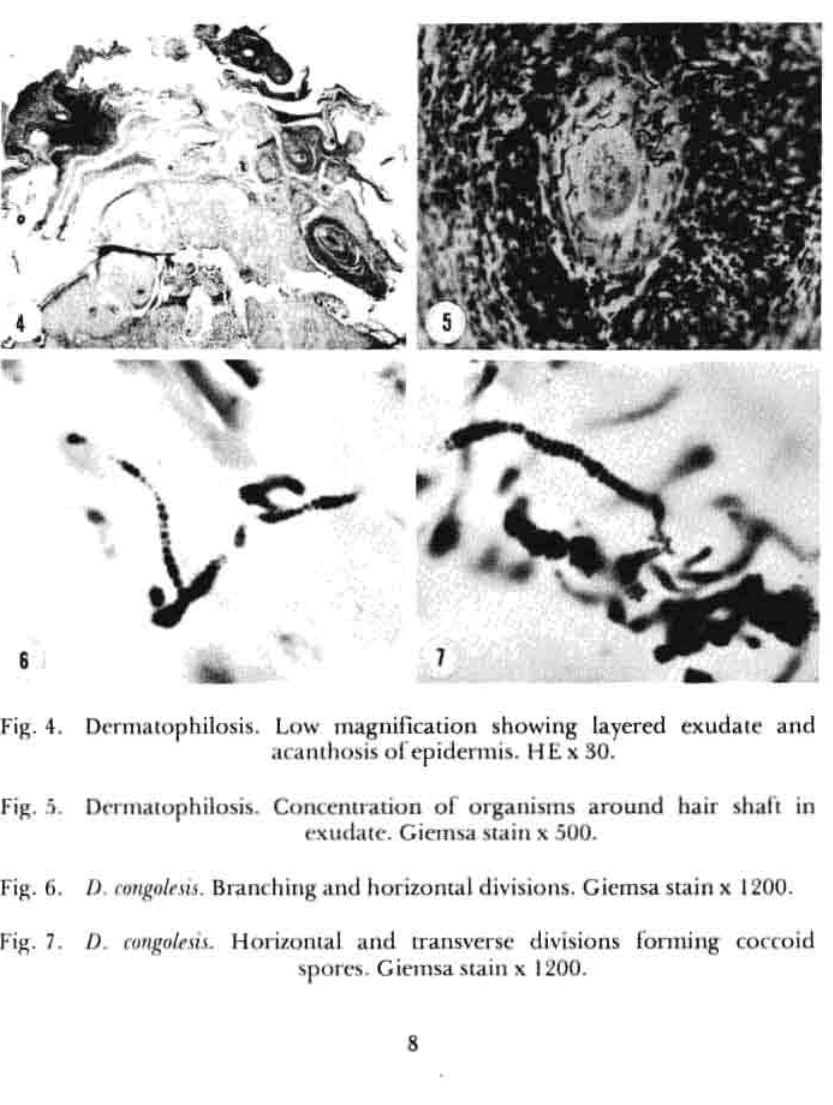
Fig. 4. Derma tophi los i s. Fig. 5. Dennatophilosis. Fig. 6. D. cOllgoltJjs. Branching and horizontal divisions. Giemsa Slain x I ZOO. Fig. 7. D. (ollgoltJiJ. Horizontal and transvcrse divisions fanning coccoid spores. Giemsa stain x